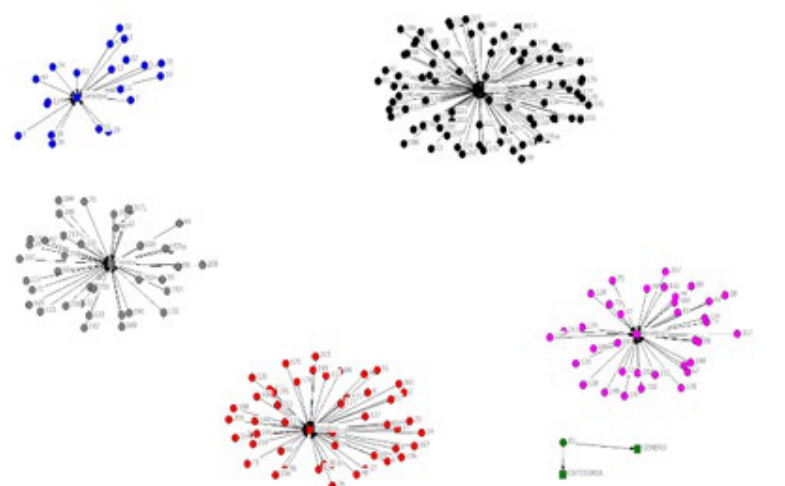
Figure 13. Graphs of messages without categories according to their